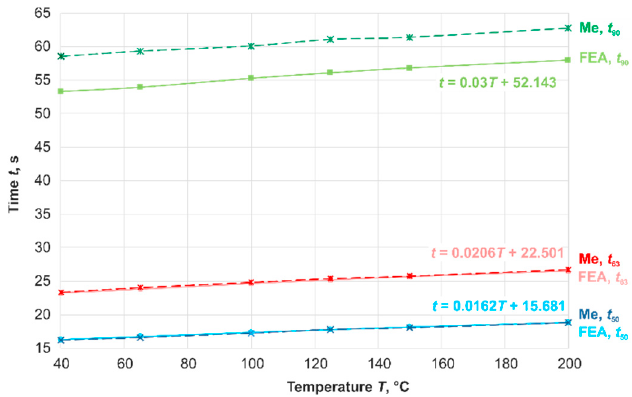
Figure 8. Comparison of the results of FEA calculation and measurement (Me) for the industrial resistance thermometer shown in Figure 7.